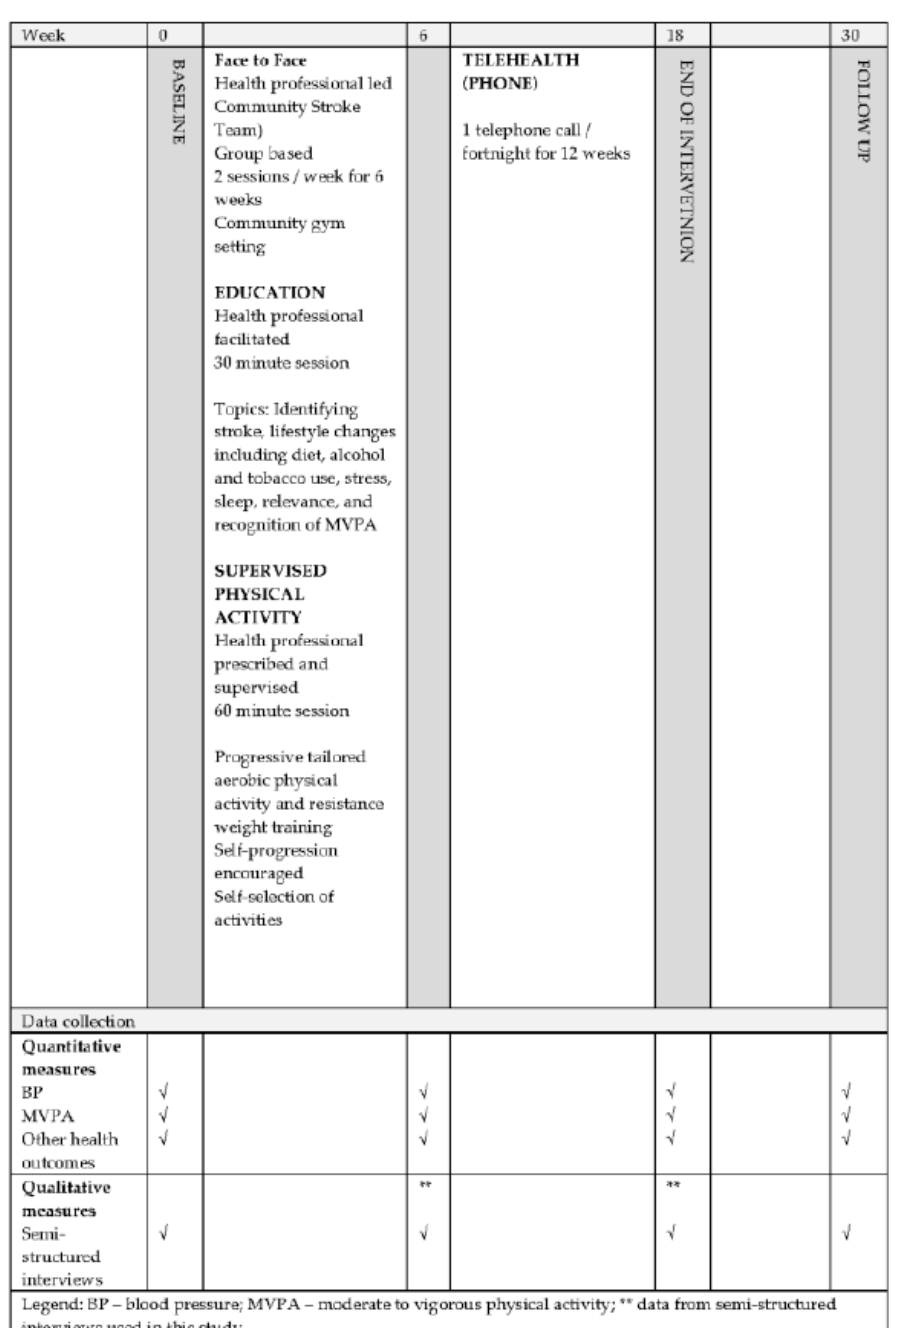
Figure 1. Timeline of secondary stroke prevention program and data collection .